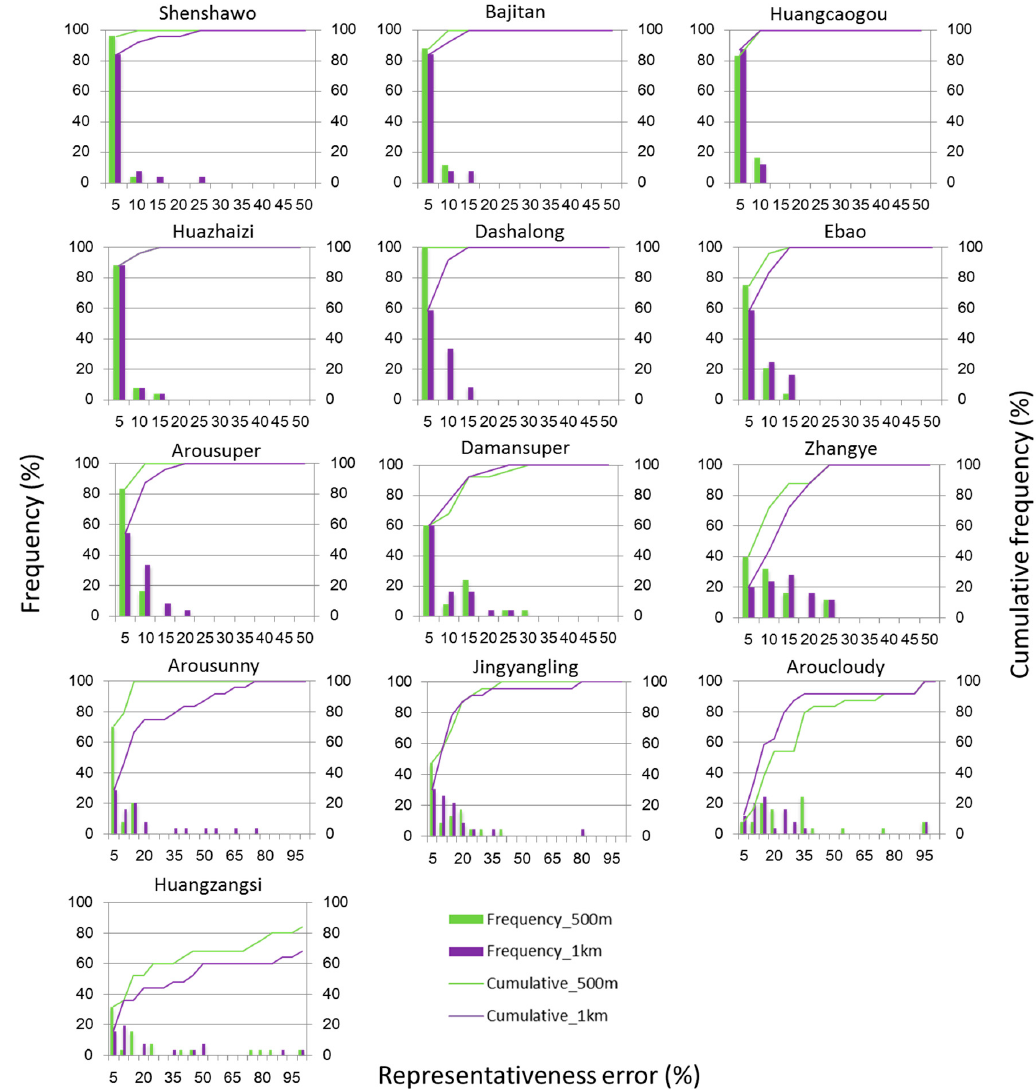
Figure A1. Frequency distribution histogram and cumulative frequency of representativeness errors of ground sites with respect to the 500 m and 1 km pixel scale albedos.